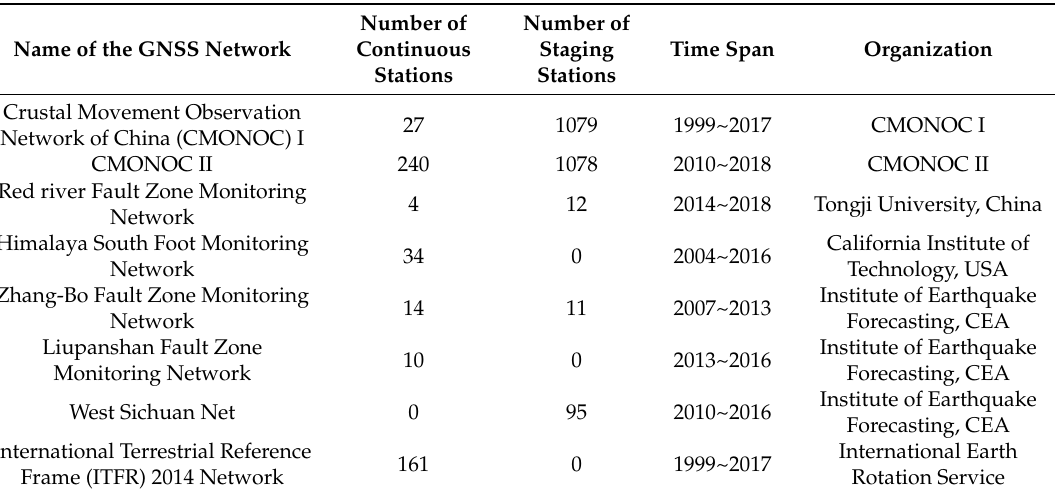
Table 1. The information on GNSS